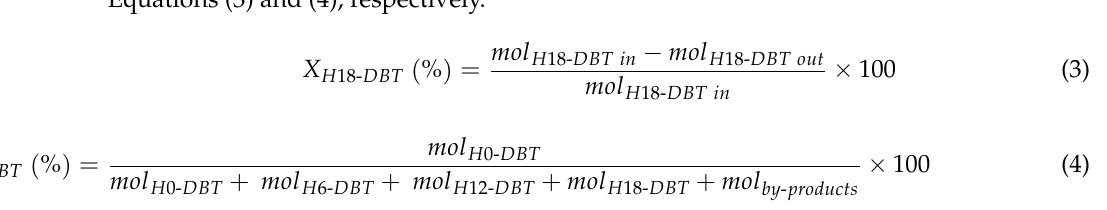
Figure 1. Catalytic performance evaluation of CAT-A, CAT-B and CAT-C: ( a ) Comparison of the initial stability of the catalysts based on the dod over 10 dehydrogenation runs; ( b ) initial activity and stability of the catalysts based on productivity vs. number of runs; ( c ) conversion of H18-DBT based on runs 1 and 10; ( d ) selectivity of catalysts towards H0-DBT based on runs 1 and 10; ( e ) deactivation over 10 dehydrogenation runs; ( f ) turnover frequency of catalysts for dehydrogenation of H18-DBT. Reaction conditions: batch reactor, reaction time 100 min for each run, reaction temperature 300 ◦ C, catalyst Pt/Al 2 O 3 , mol. ratio: n Pt /n H18-DBT (99.7doh) = 0.05 mol %. The H18-DBT conversion ( X ) and H0-DBT selectivity ( S ) were calculated using Equations (3) and (4),